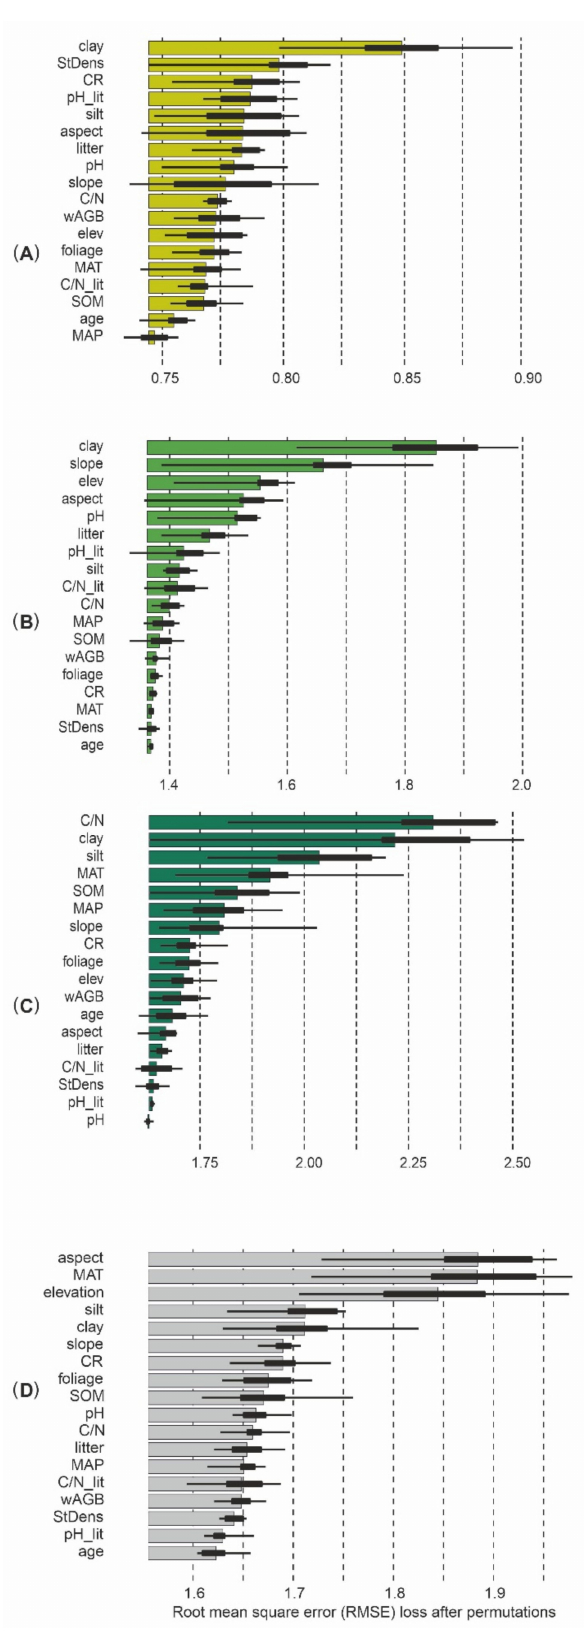
Figure 7. Importance of variables in FRB content models for beech ( A ), spruce ( B ), fir ( C ) forest and all plots ( D ). This importance is expressed by a loss-drop in RMSE when a given variable is perturbed. Abbreviations—see explanation in Table